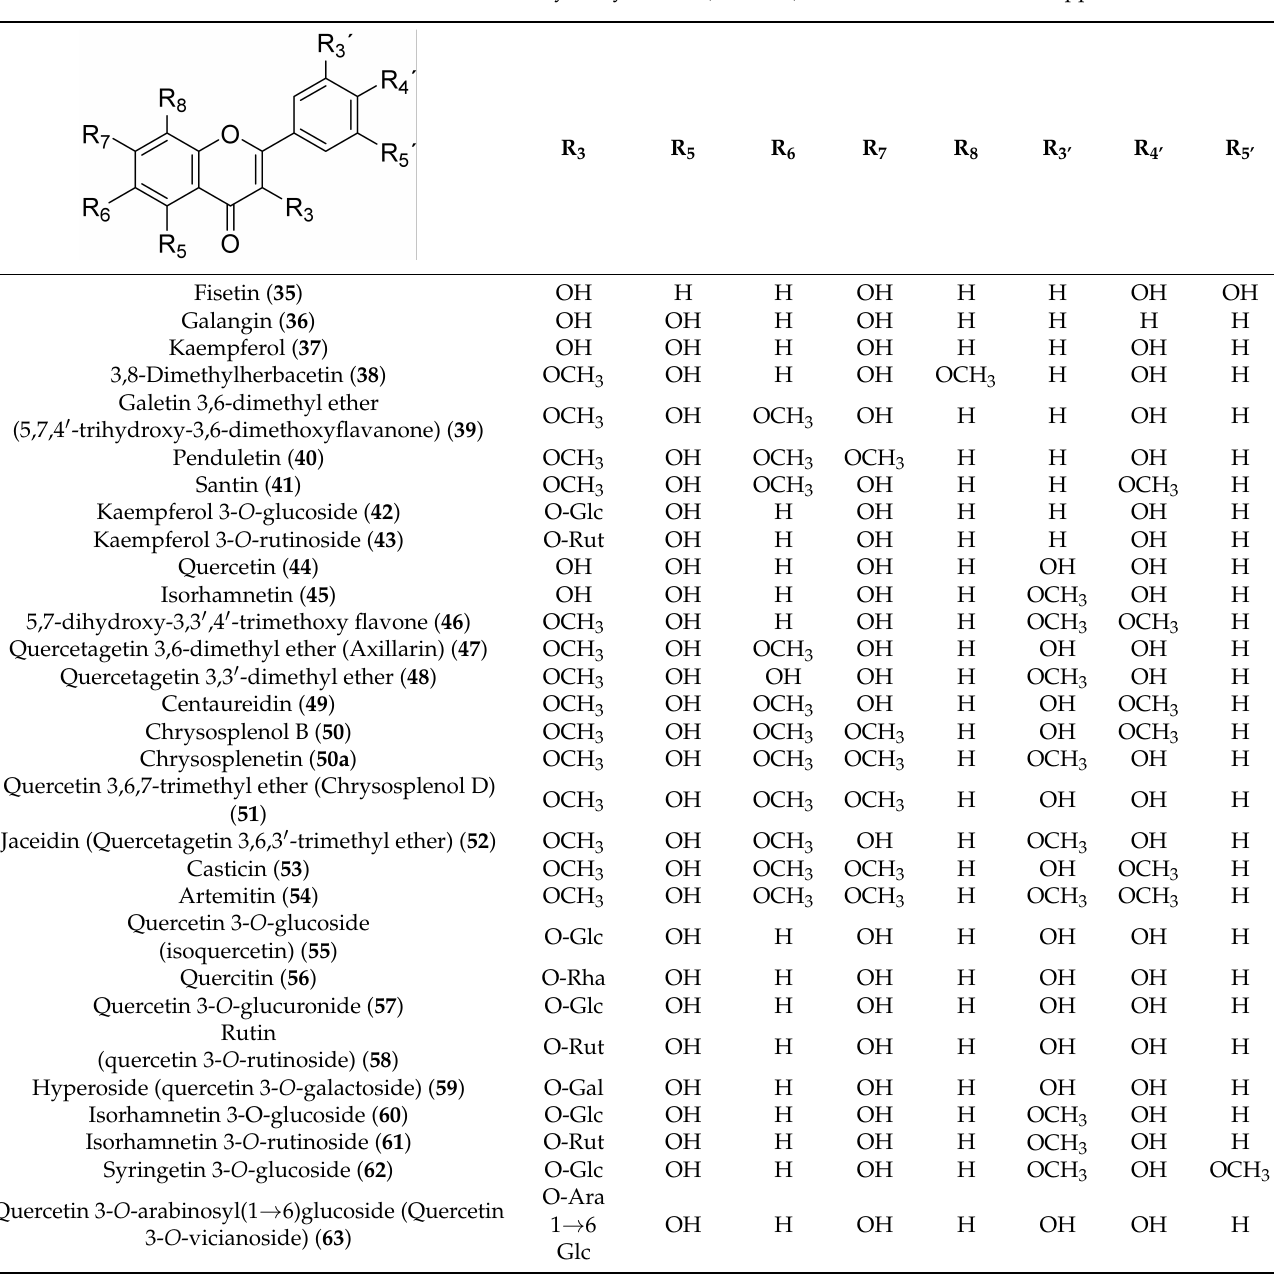
Table 4. Chemical structures of the 3-Hydroxyflavone (flavonol) derivatives from Achillea